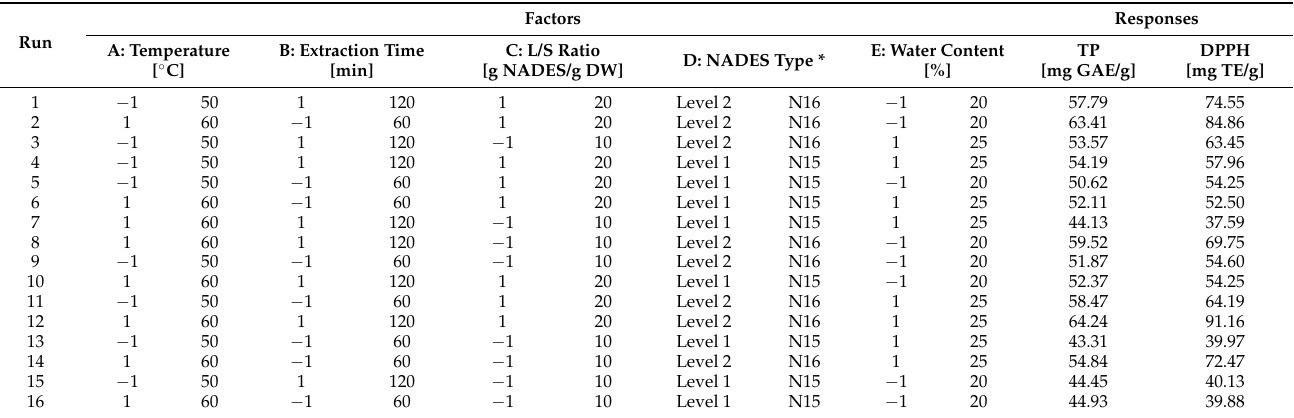
Table 1. 2 5 − 1 fractional factorial design was used for the preliminary study with the experimental domain of the independent factors and observed values of target